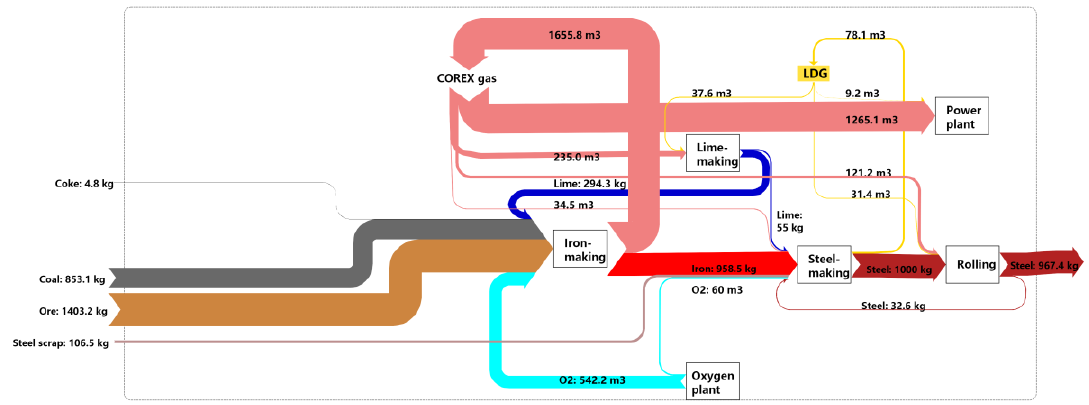
Figure 6. Chart of the material flows of an ISP with the COREX.